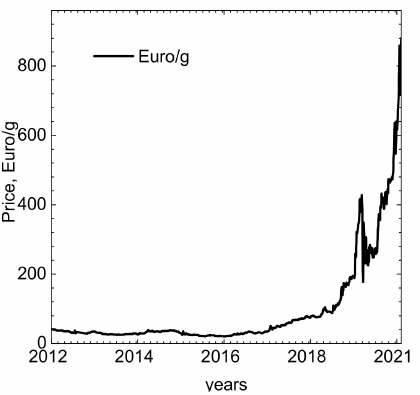
Figure 1. Rhodium price evolution over the last decade